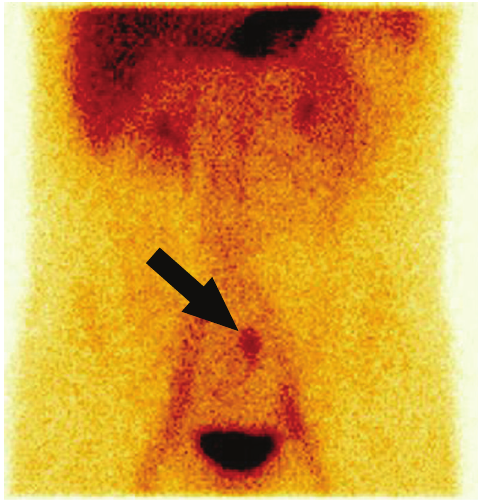
Figure 3: 24-year-old man with enterorrhagia. Meckel’s diver- ticulum scintigraphy, anterior view, 20 minutes after intravenous injection of 99 m Tc-pertechnetate disodium. Radiotracer uptake in the ectopic gastric mucosa in the left hypogastrium ( arrow head